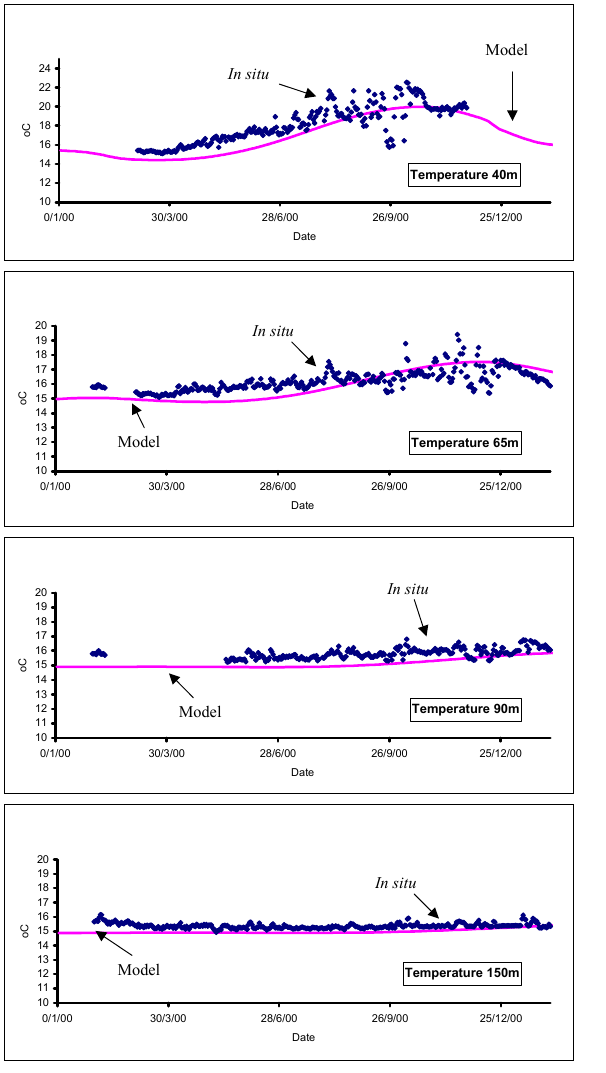
Fig. 3. Validation of model temperature with CTD measurements at 40, 65, 90 and 150m.